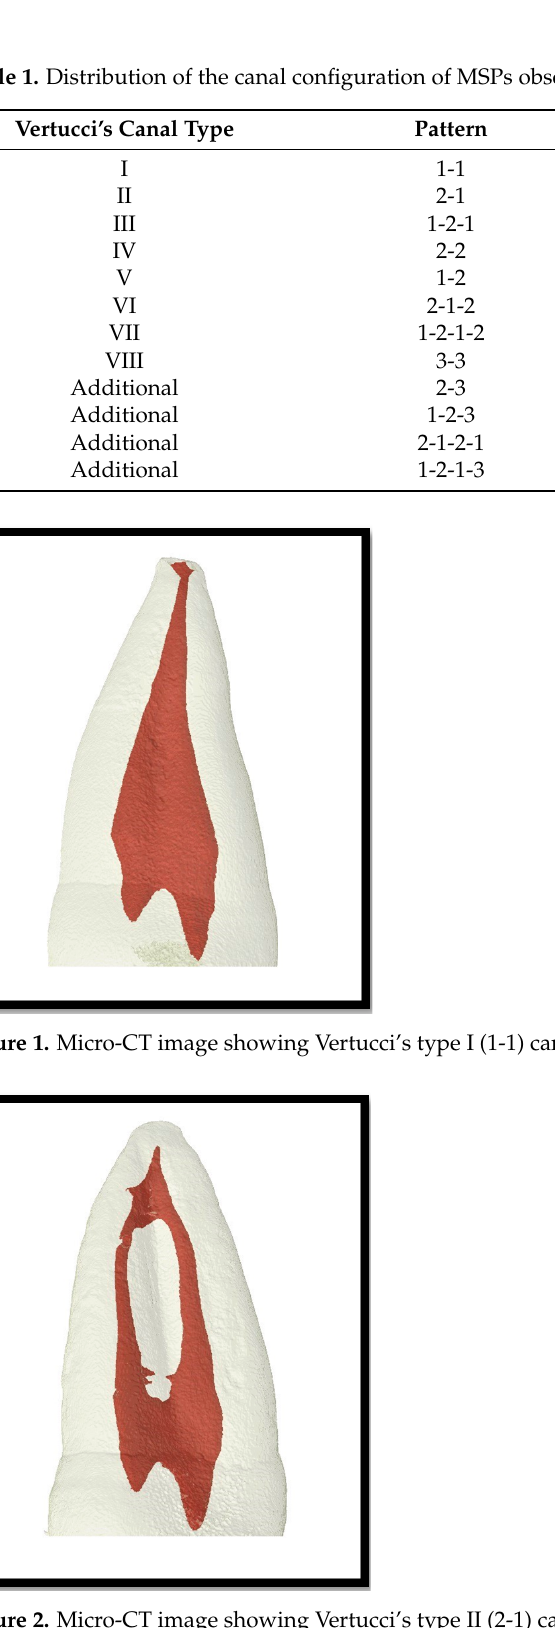
Figure 3. Micro-CT image showing Vertucci’s type III (1-2-1) canal configuration. Figure 4. Micro-CT image showing Vertucci’s type IV (2-2) canal configuration.